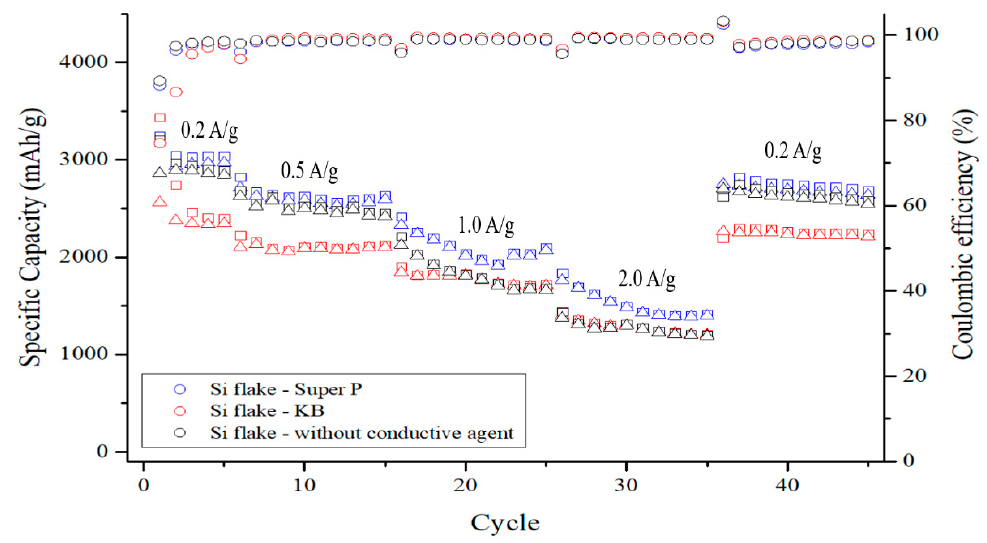
Figure 11. Cycling performance of pyrolyzed anodes made of: (1) silicon flake:Super P:binder = 70%:10%:20% by weight, (2) silicon flake:KB:binder = 70%:10%:20% by weight, and (3) silicon flake:binder = 70%:30% by weight at discharge–charge rates varied from 0.2 A/g (0.05 C) to 2 A/g (0.48 C). The discharge–charge rate is based on the weight of silicon flakes.